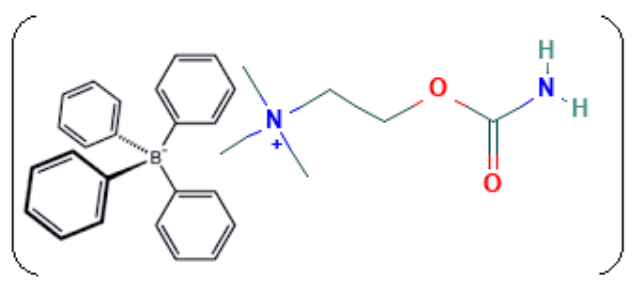
Figure 6. The proposed structural formula of the ion-association